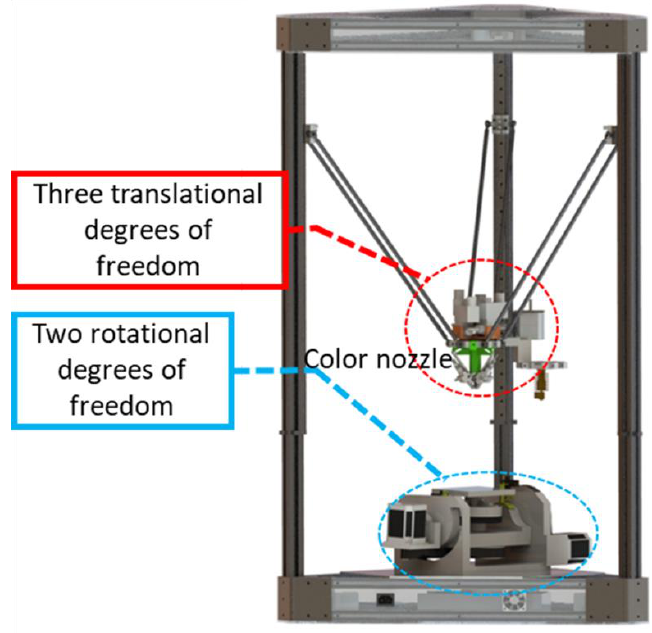
Figure 3. Five degrees of freedom (DOF) printing.